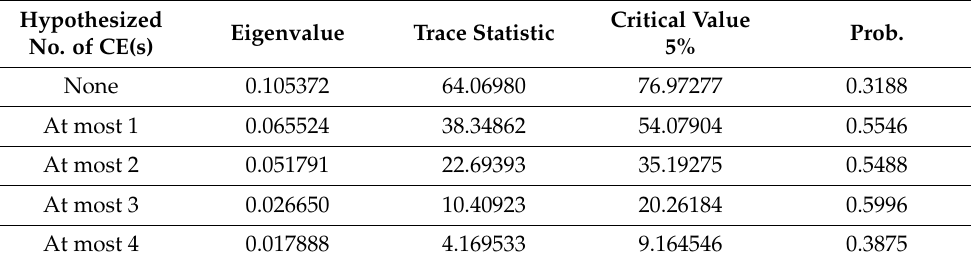
Table 8. Trace statistic—Johansen cointegration method (post-vaccine period).